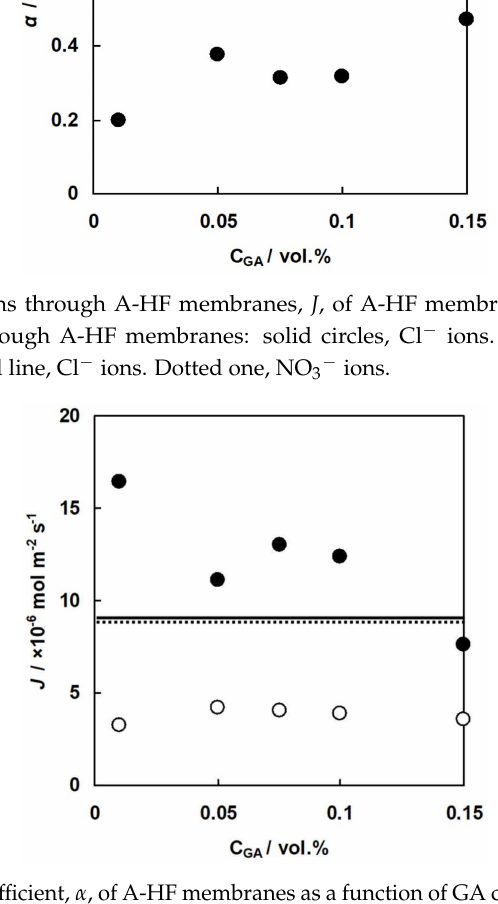
Figure 16. Selectivity coefficient, α , of A-HF membranes as a function of GA concentration. Solid circles, A-HF membranes. Solid line,